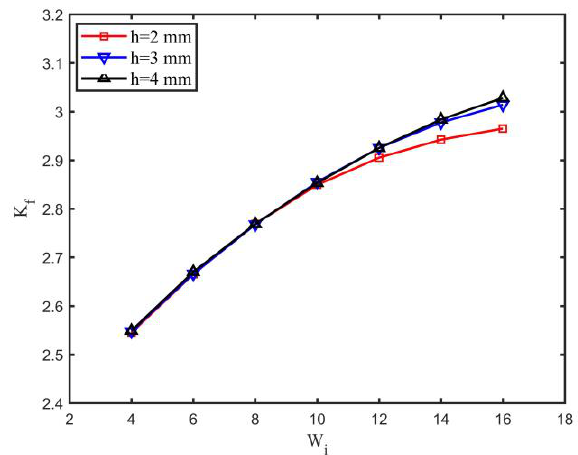
Figure 8. The effect of weld root bead width Wi (δ = 0, θ = 50°).